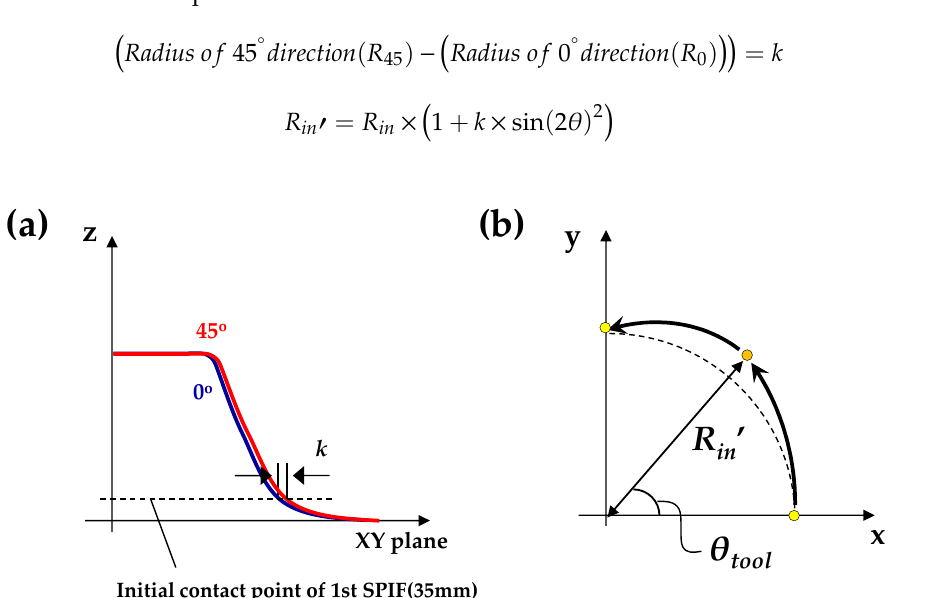
Figure 11. Schematic figure of ( a ) the sectional view along 0° and 45°; ( b ) modified tool path in the counter SPIF for compensation of the round.